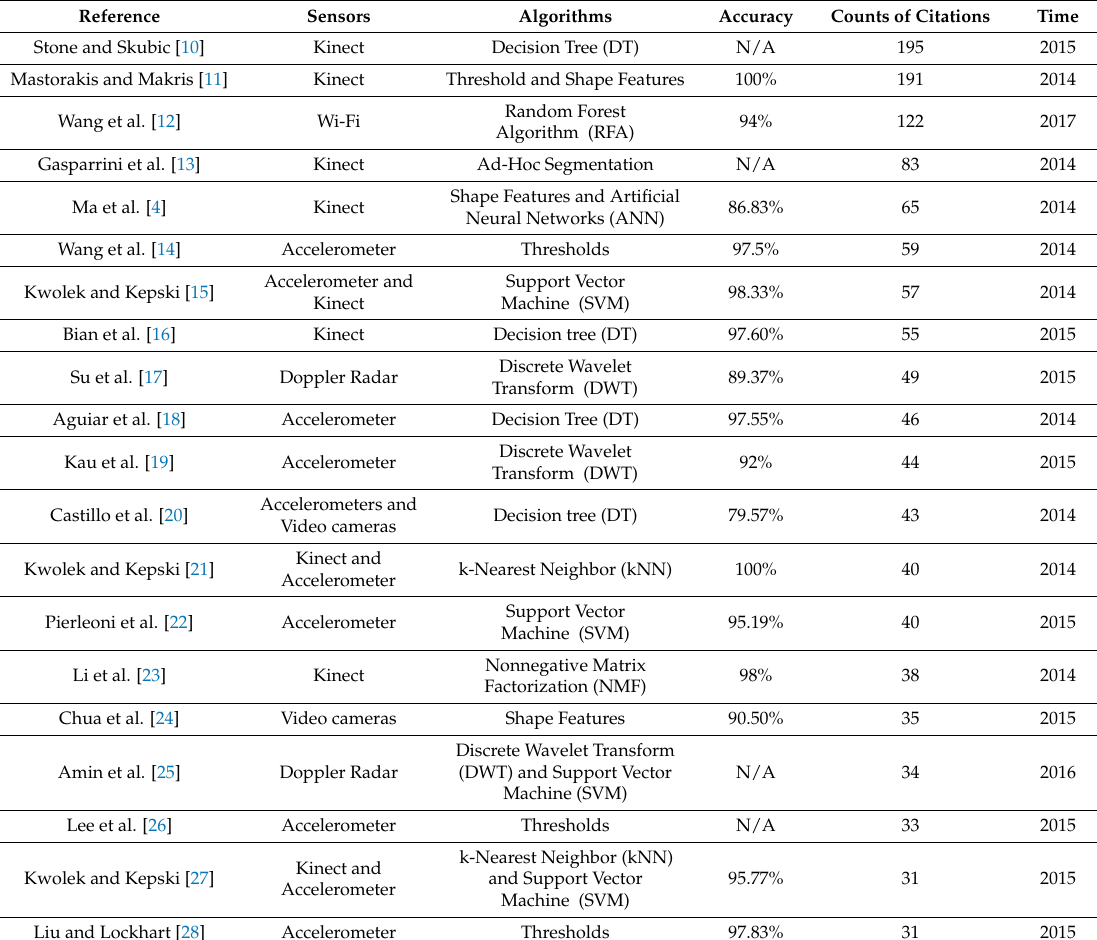
Table 1. Twenty most cited papers on fall detection published from